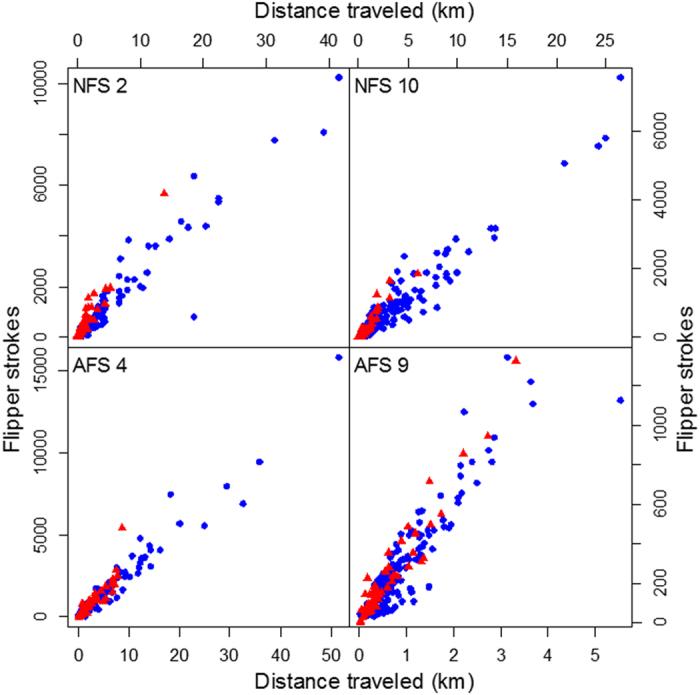
Number of flipper strokes detected per distance traveled vertically while diving (red triangles) and horizontally while transiting near the surface (blue circles) for 2 northern fur seals (NFS 2 and NFS10) and 2 Antarctic fur seals (AFS 4 and AFS 9) between 2 GPS locations during a foraging trip.Transiting at the surface is defined as periods of time when animals travel at speeds > 1 m/s between 2 GPS locations.